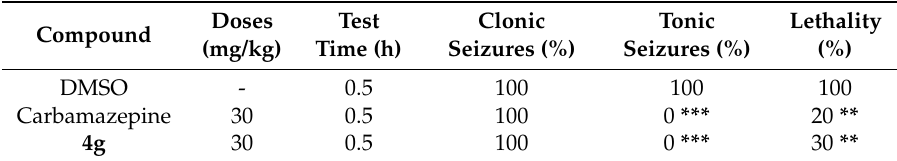
Table 4. Effect of compound 4g on Bicuculline-induced seizures in mice.